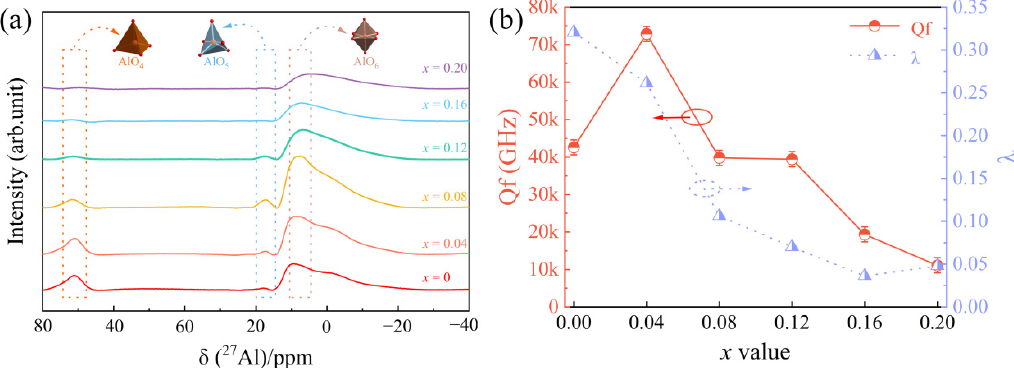
Figure 5. ( a ) 27 Al NMR spectra of Mg 1 − x Cu x Al 2 O 4 ceramics sintered at 1550 °C; ( b ) the effects of the degree of inversion on Qf value at 1550 °C.